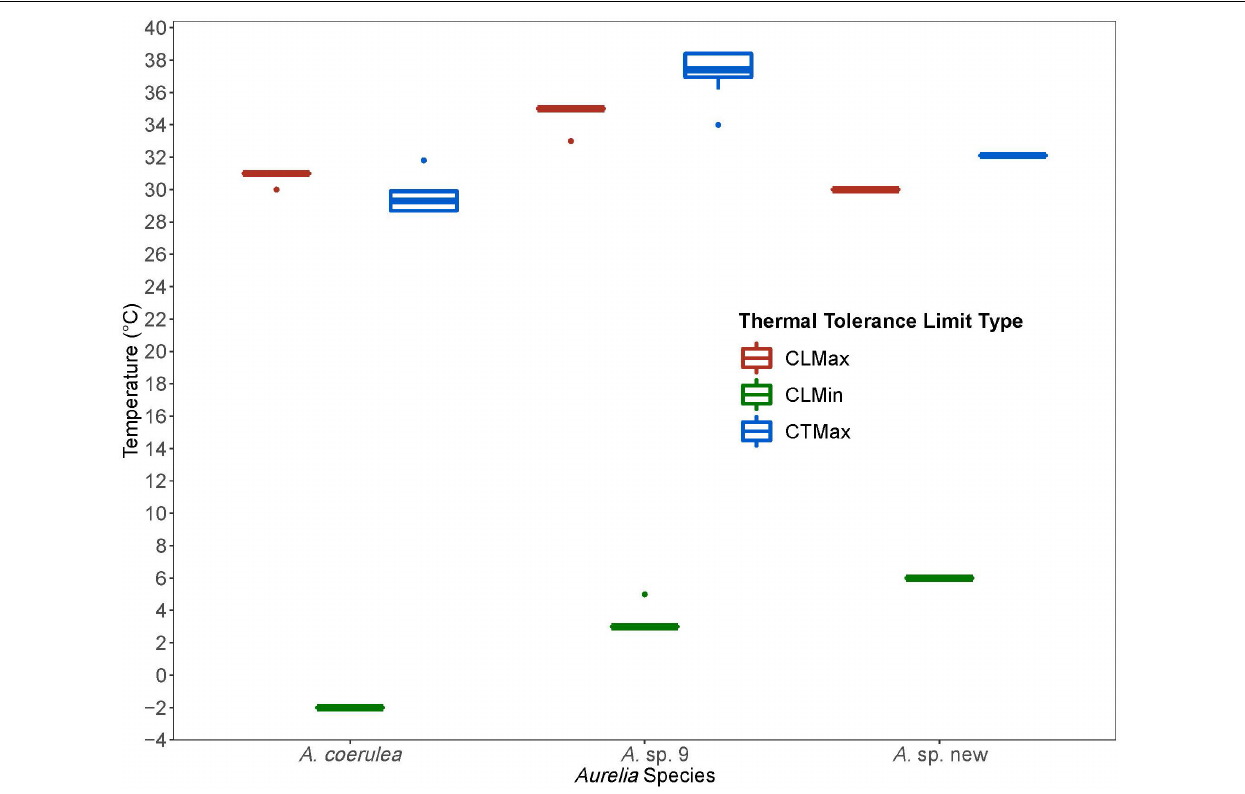
FIGURE 4 | Comparison of thermal tolerance values from Chronic Lethal Maximum and Minimum and Critical Thermal Maximum experiments for Aurelia coerulea, A. sp. new, and A. sp. 9. Thermal limits are in degrees Celsius ( ◦ C). Colors designate thermal limit type: red is Chronic Lethal Maximum (CLMax), green is Chronic Lethal Minimum (CLMin), and blue is Critical Thermal Maximum (CTMax). Boxplots displays the median with the lower and upper hinges corresponding to the 25th and 75th percentiles and whiskers extending to 1.5 times the inter-quartile range. Single points indicate